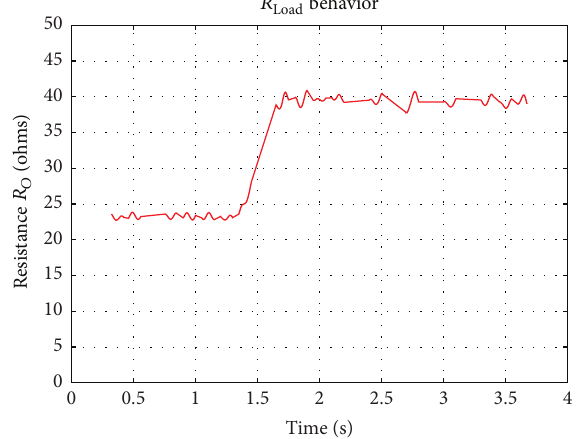
Figure 23: P-I characteristic curve from experimental data. Figure 24: Behavior of the load resistance 𝑅